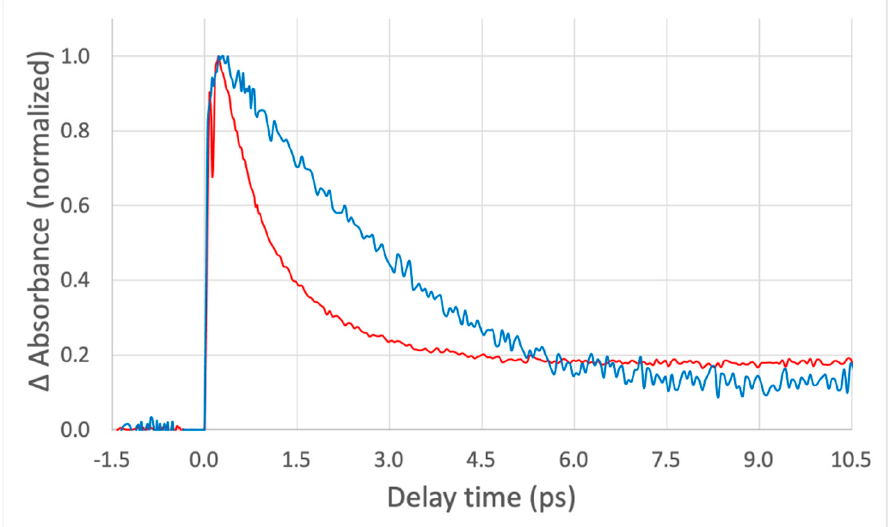
Figure 9. Kinetic trace extract at the maximum of the winglet to the blue of the Au plasmon bleach after excitation at 620 nm: FTO/Au NPs (blue trace) and FTO/Au NPs/p-Cu 2 O (red trace).